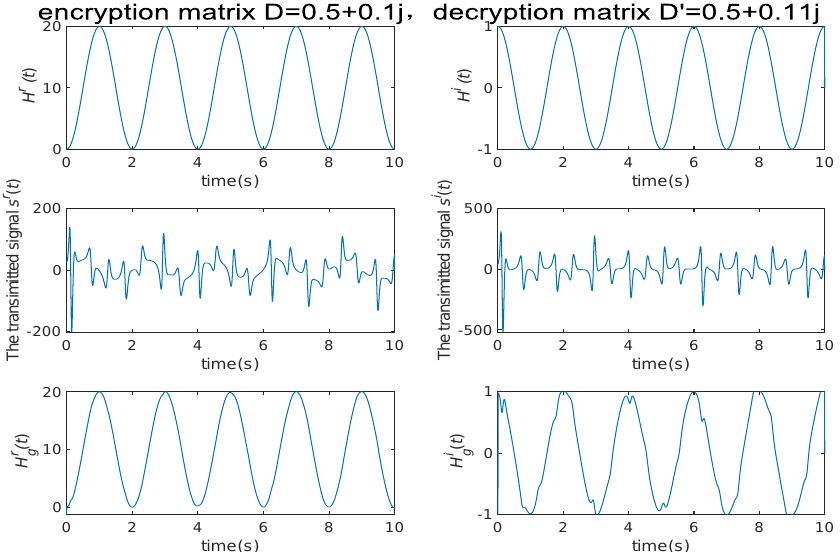
Figure 11. The CMPDFS process with D = 0.5 + 0.1 j and D (cid:48) = 0.5 + 0.11 j .